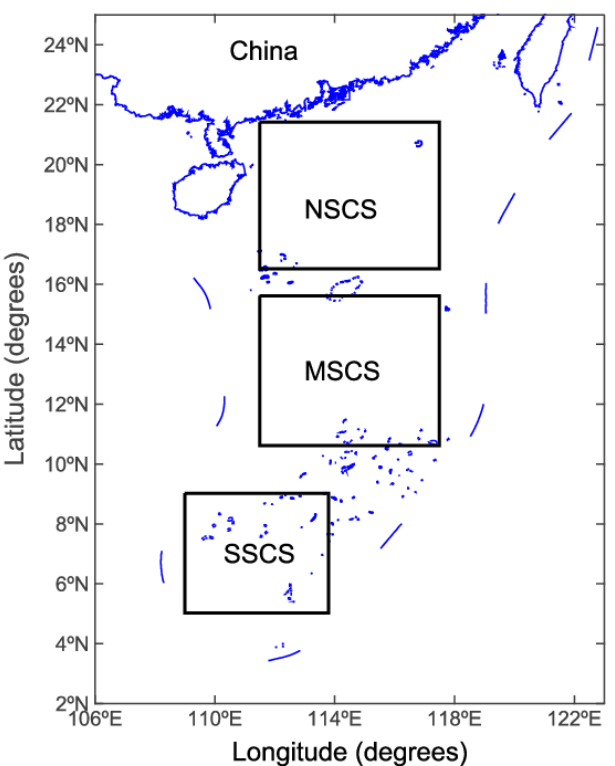
Figure 1. Map of the South China Sea (SCS). The black boxes represent the three selected regions of interest: the northern part of the South China Sea (NSCS), the middle part of the South China Sea (MSCS), and the southern part of the South China Sea (SSCS).